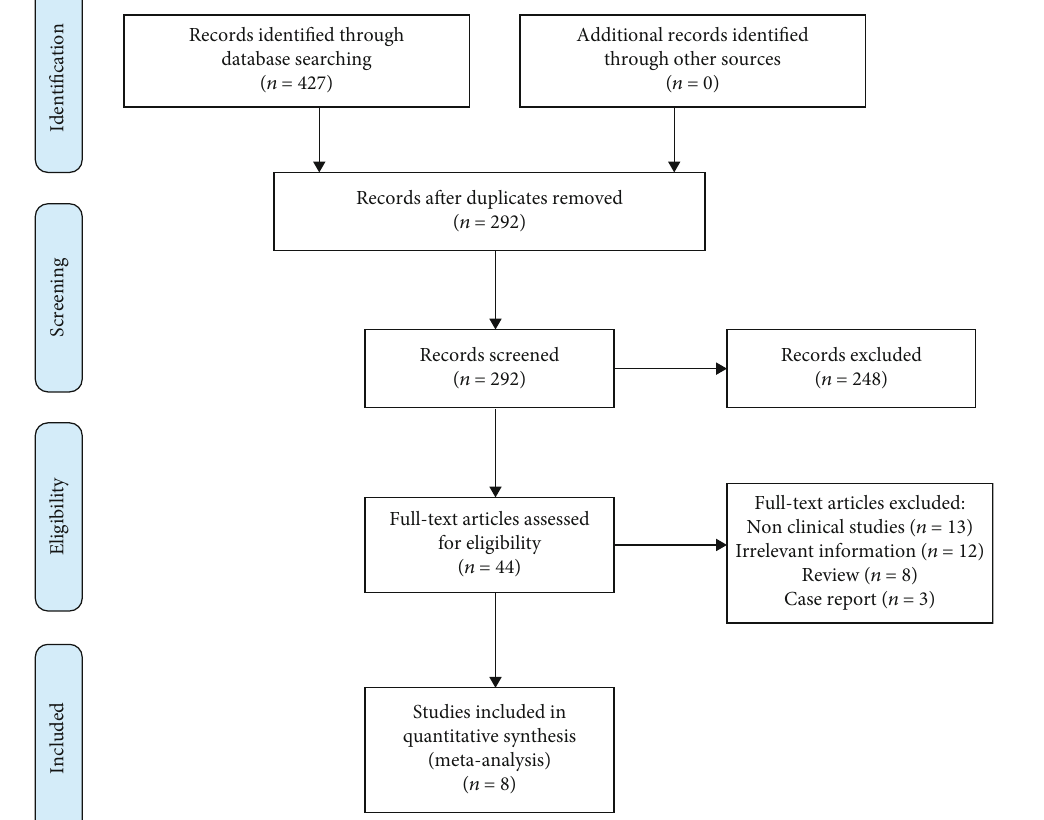
Figure 1: Flow diagram of the study selection